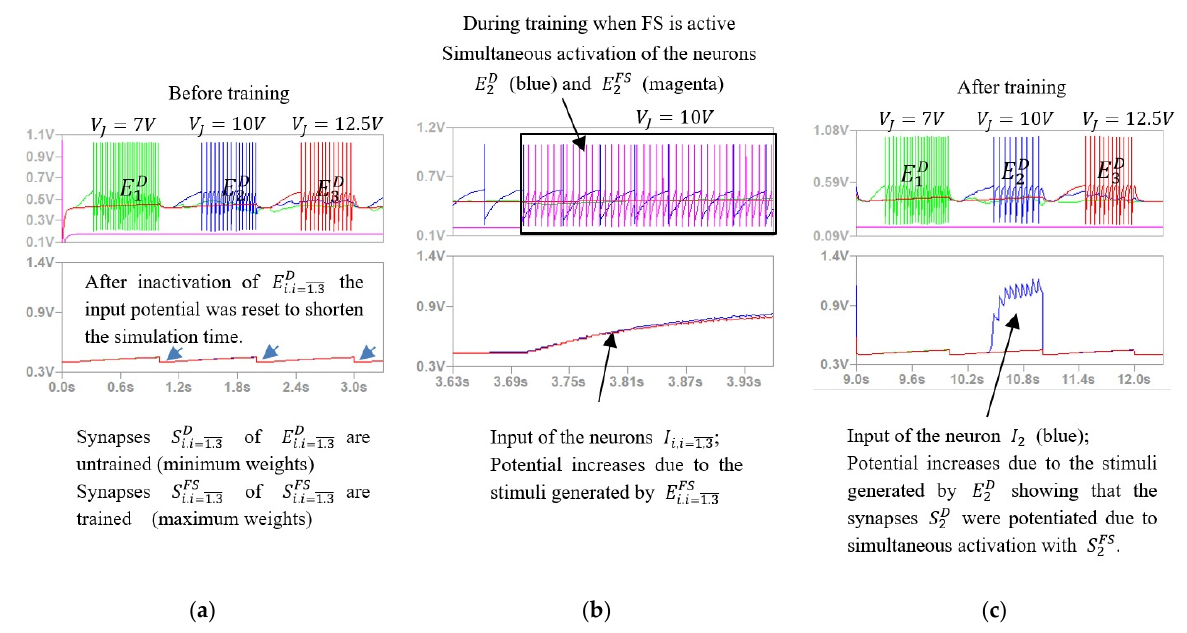
Figure 4. Simulation results showing: ( a ) the activity of the excitatory neurons 𝐸 (cid:2869)(cid:3005) , 𝐸 (cid:2870)(cid:3005) and 𝐸 (cid:2871)(cid:3005) (green, blue, and red signals) that respond to predefined voltage levels corresponding to the angle intervals; ( b ) a magenta signal showing the activity of the excitatory neurons that are stimulated by the force sensor ( c ) neuron activity after training, showing the effect of the potentiated synapses that were activated simultaneously with the force sensor.